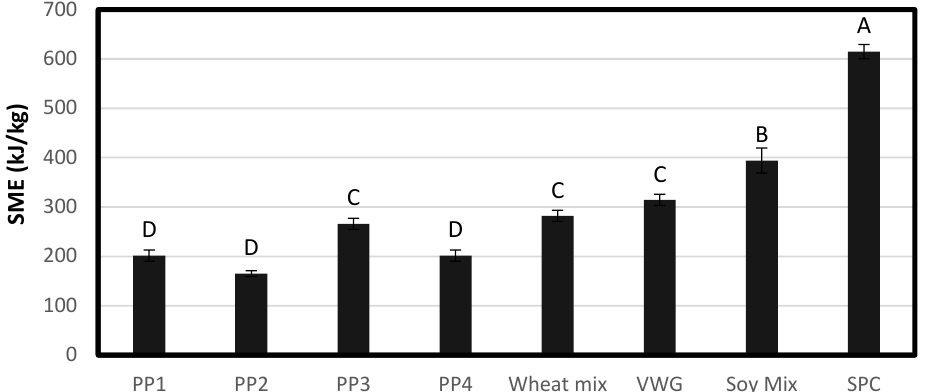
Figure 9. Flow temperature for raw material treatments and moderately sheared extrudate. Bars denoted by the same letter are not significantly different ( p < 0.05). Wheat gluten was not able to be hydrated and extruded on the lab-scale extruder, thus no extruded PTA test was conducted on Wheat Mix and VWG.